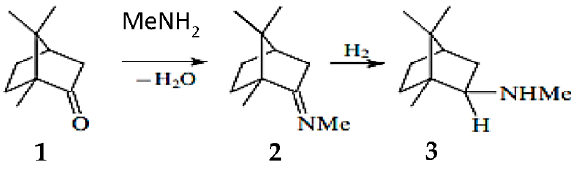
Figure 7. Reductive amination of camphor ( 1 ) with methylamine for synthesis of N -methylbornan-2- ylamine. Adapted from [68].